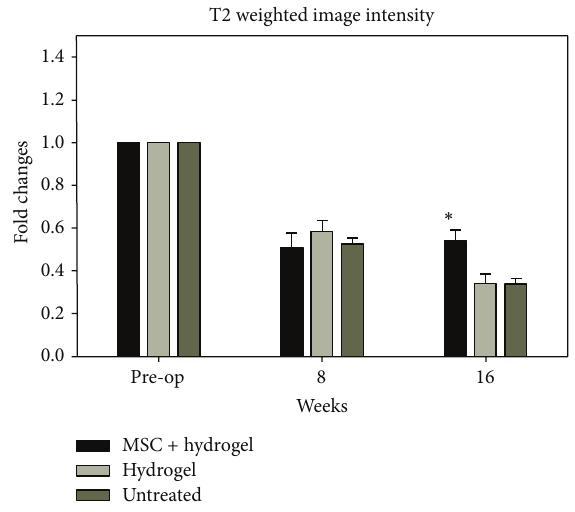
Figure 6: Magnetic resonance imaging results of normalized T2 values. Magnetic resonance imaging (MRI) analysis was performed before operation, 8 weeks after defects were created, and 8 weeks after transplantation (16 weeks). The normalized T2 value of group I after transplantation with MSC + hydrogel shows significant difference between group II and group III. ∗ indicates significance at 𝑃 < 0.05 .